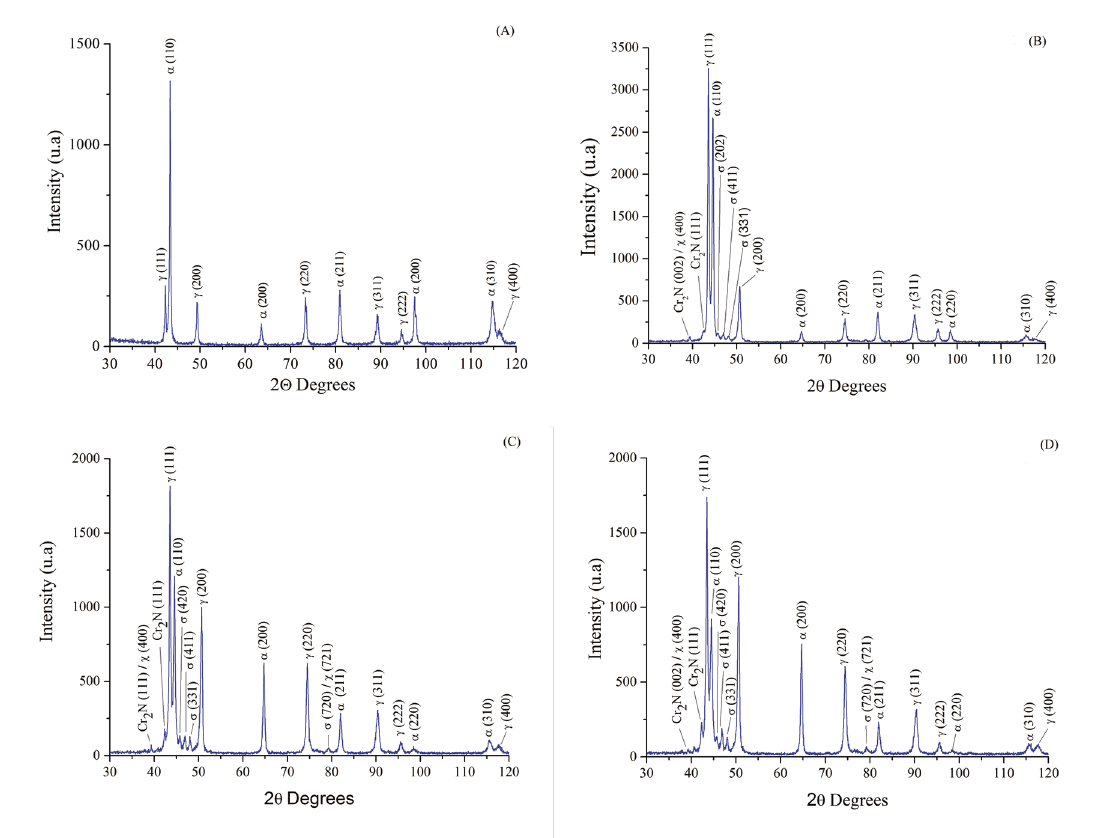
Figure 6. Diffractograms samples A) As-received, B) 30 minutes, C) 90 minutes and D) 180